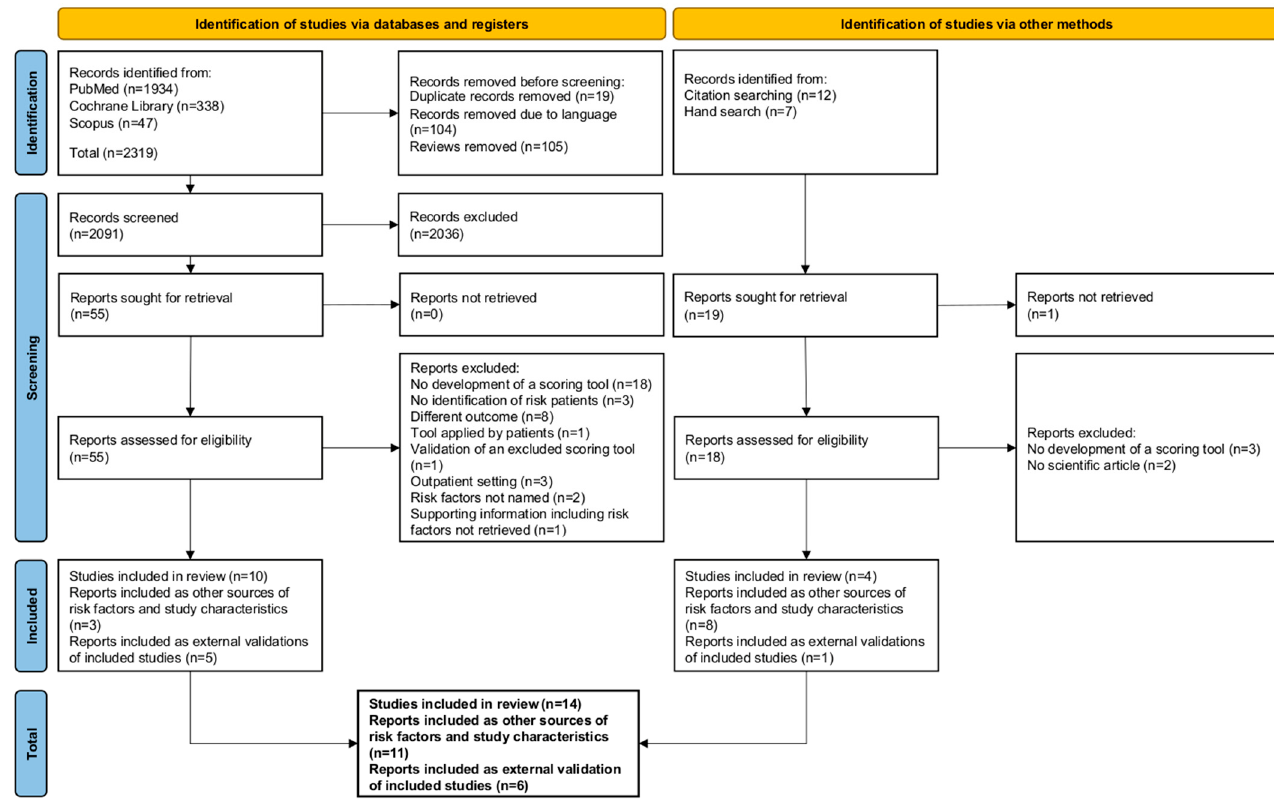
Figure 2. Study selection process displayed as a PRISMA flow